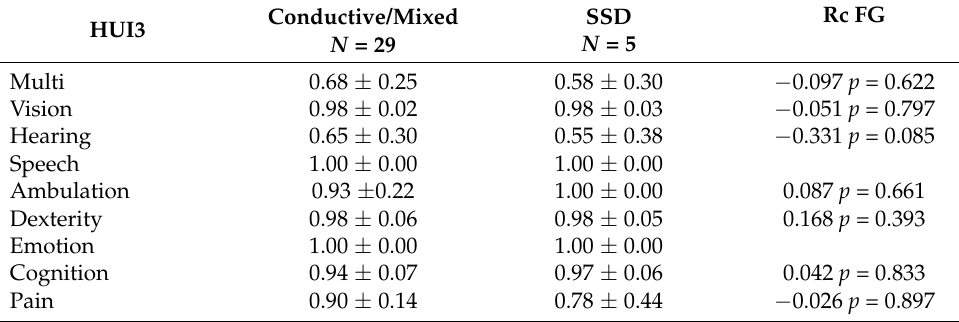
Table 5. Health Utility